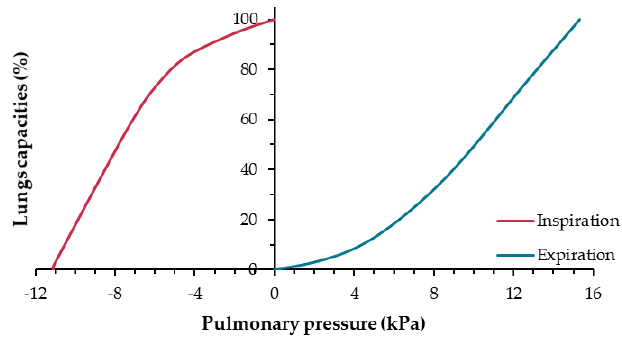
Figure 4. Pressure-volume diagram of breathing with the minimal inspiratory (red) and the maximal expiratory (blue) pressures adapted from [7].